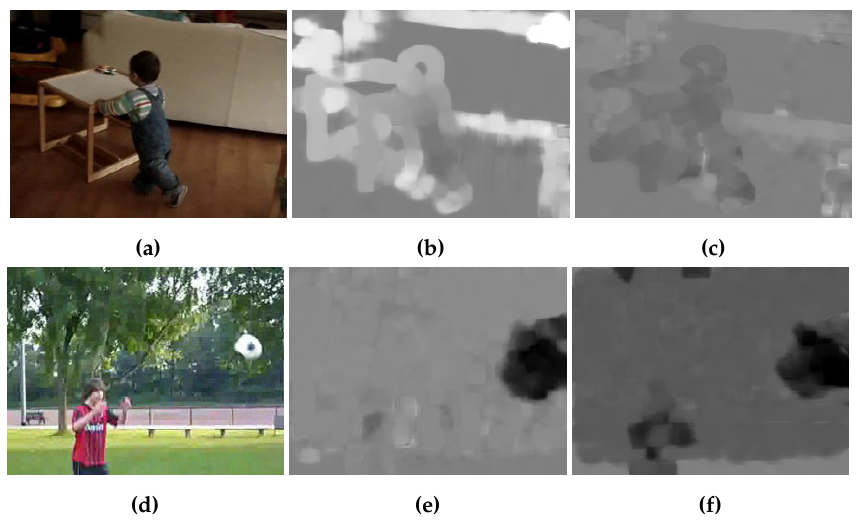
Figure 3. Images of TV-L1 optical flow. ( a , b ) shows original RGB images. ( d , e ) shows x-axis TV-L1 Sensors 2020 , xx , 5 optical flow images. ( c , f ) shows y-axis images